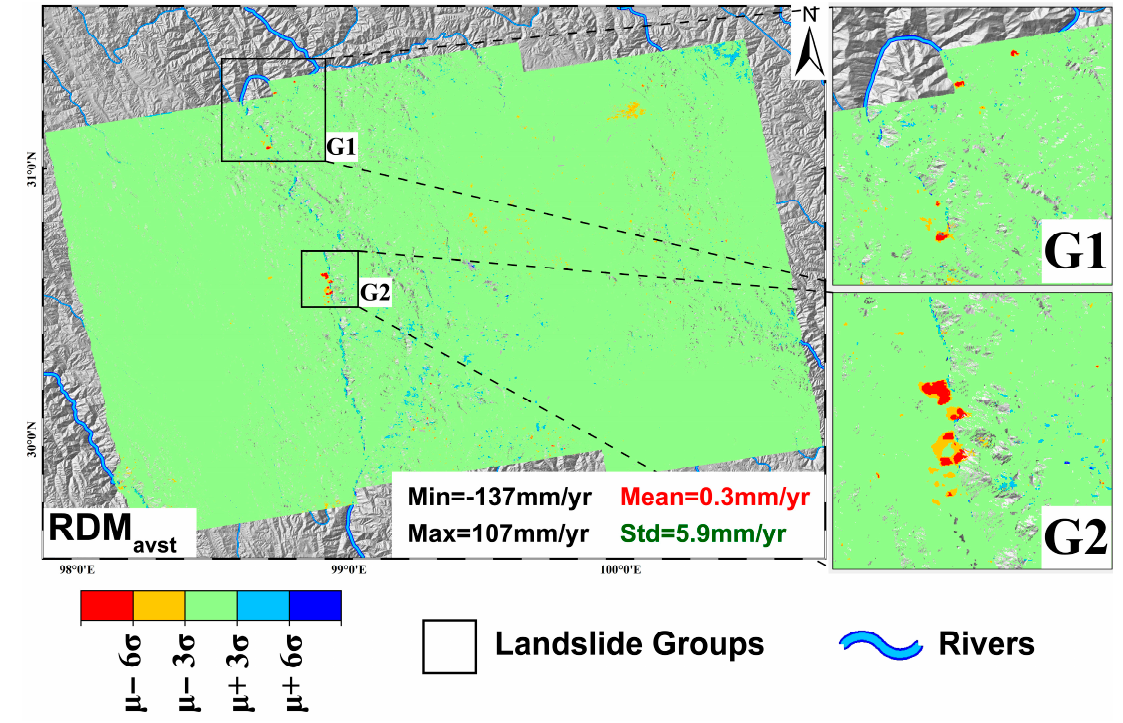
Figure 11. Annual velocity map obtained by stacking.